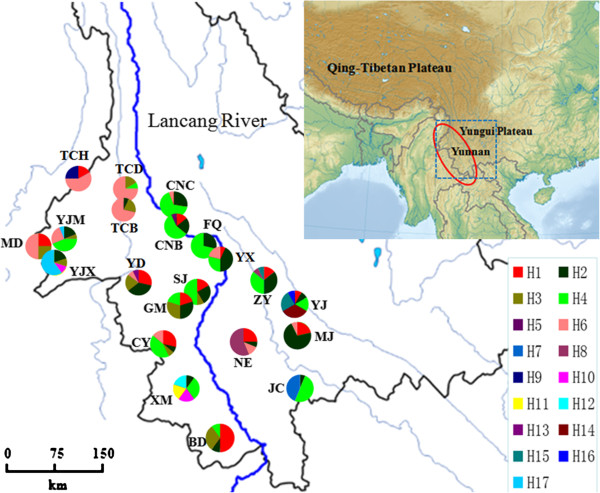
The geographical distribution of 17 PAL haplotypes in the 21 C. taliensis populations.  The Lancang River is indicated in blue, while red circle showes the range of the species.